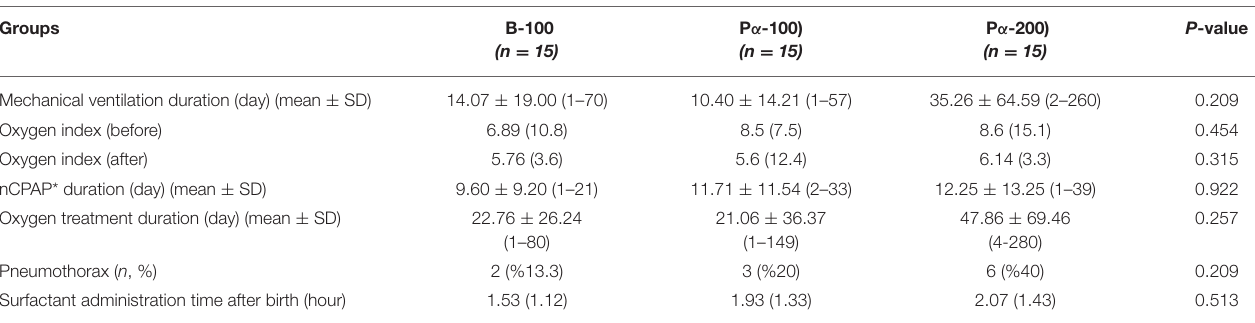
TABLE 2 | Comparison of respiratory follow-up of the groups.